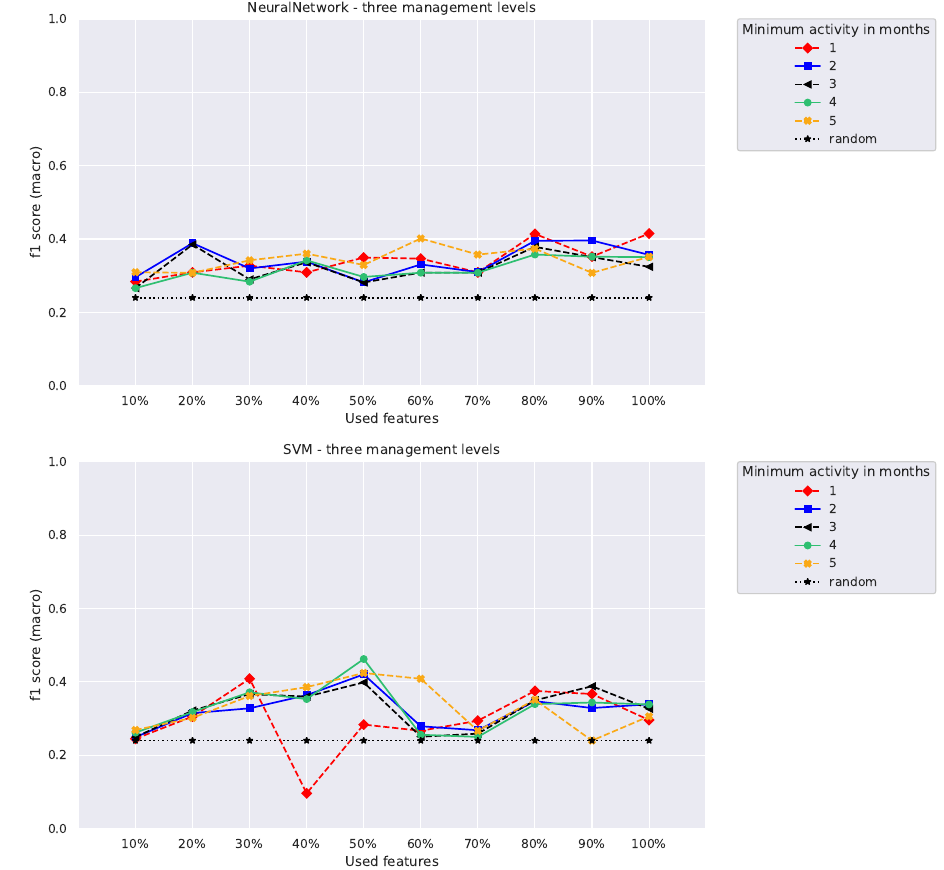
Figure 4. The result of the classification of three groups for the manufacturing company dataset.